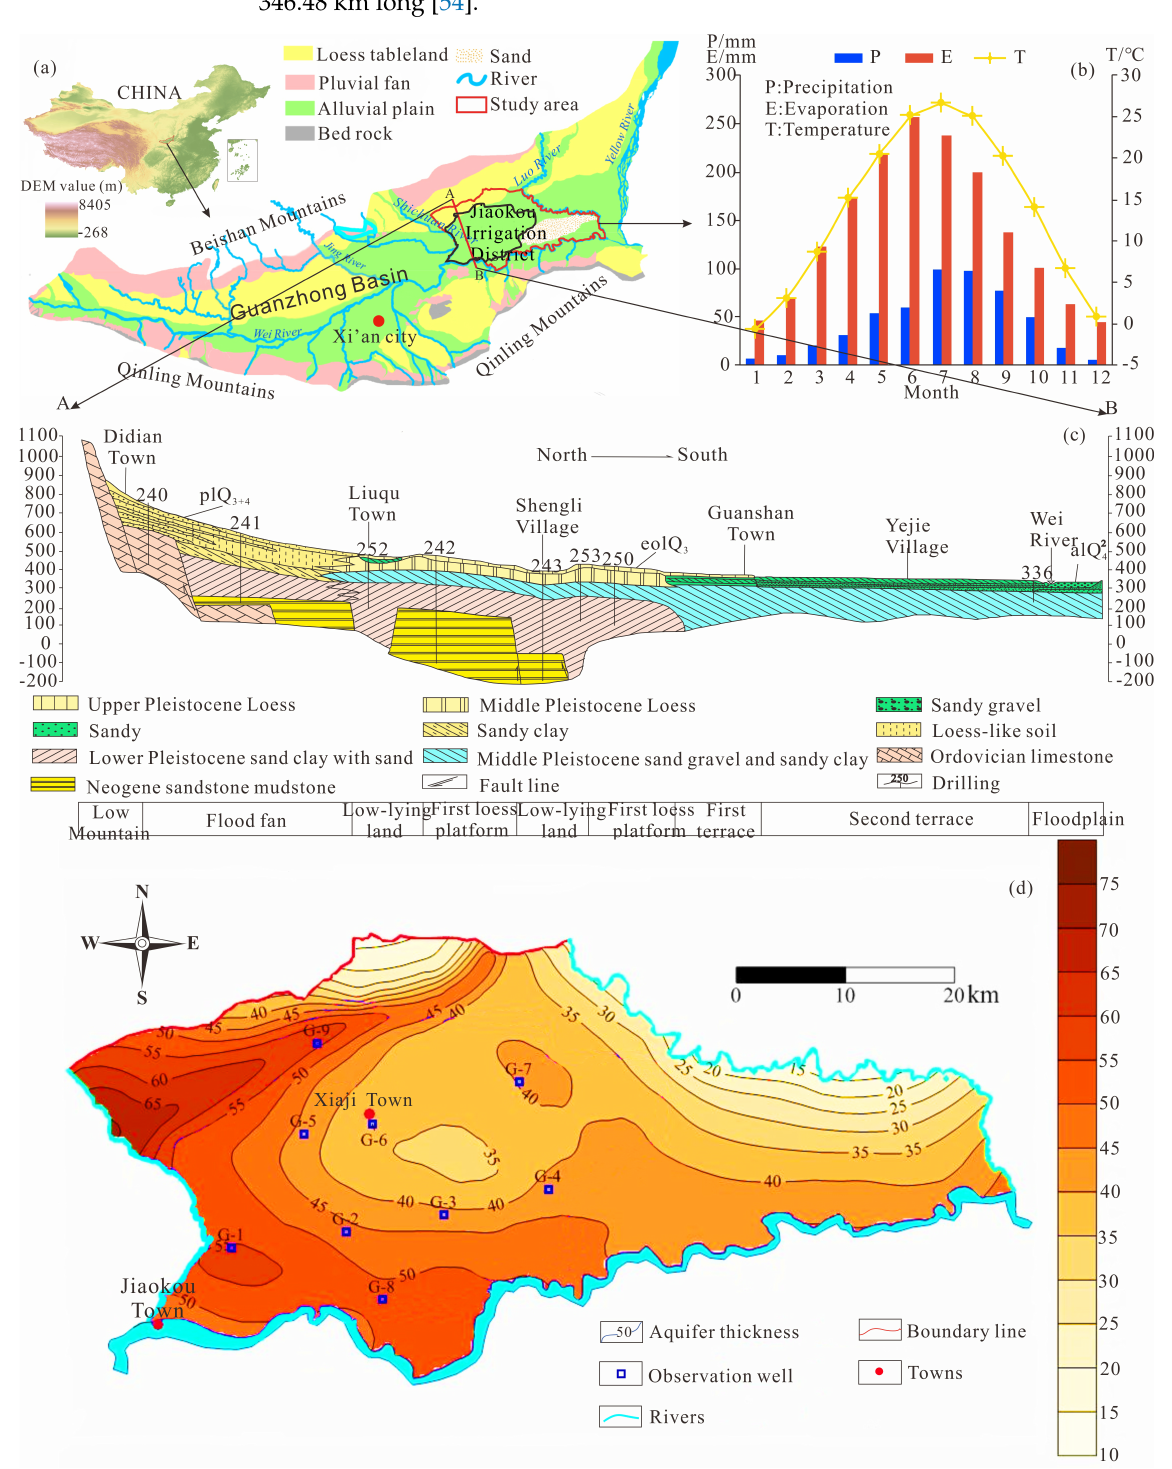
Figure 1. Study area map showing ( a ) locations and geomorphology, ( b ) meteorological elements, including precipitation (P), evaporation (E), and temperature (T), ( c ) stratigraphic profile, and ( d ) aquifer